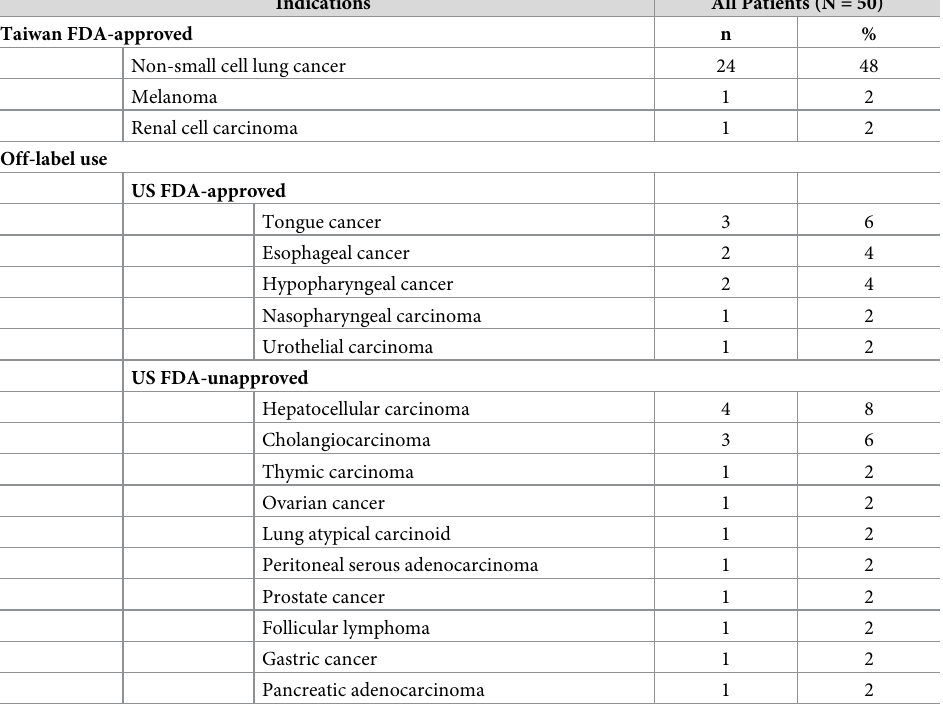
reached, and the PFS for males was 11.53 months, while they the median OS was 13 months, and the PFS was 4.43 months for female patients. For patients aged over 65, the median OS was not reached, and the PFS was 5.37 months, while the median OS was 11.53 months, and the PFS was 4.43 months for patients aged less than 65. Compared with non-squamous cell NSCLC (not reached and 4.9 months), the median OS and PFS for squamous cell NSCLC were much shorter (0.63 and 1.37 months). For patients with EGFR mutation, the OS and PFS were 11.53 months, while they were 13 and 4.9 months for EGFR non-mutation. For patients with PD-L1 positive, the OS and PFS were 13 months and not reached, while they were shorter (11.53 and 2.6 months) for PD-L1 negative patients. For Hepatitis B virus carriers, the OS and PFS were 11.53 months, while they were 13 and 4.43 months for non-carriers. The median OS was 11.53 months, and the PFS was 5.37 months for the third line treatment, while the OS was not reached, and the PFS was 2.43 months for the first line treatment patients. Table 2. Distribution of